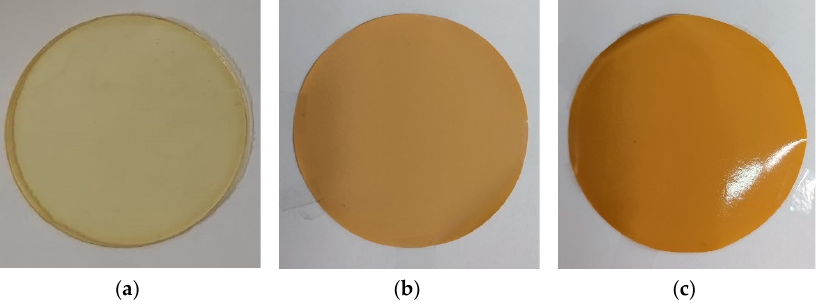
Figure 4. PTMSP ( a ), PTMSP/HCPS 50 wt%—surface principally consisting of HCPS ( b ), PTMSP/HCPS 50 wt%—surface principally consisting of PTMSP ( c ).